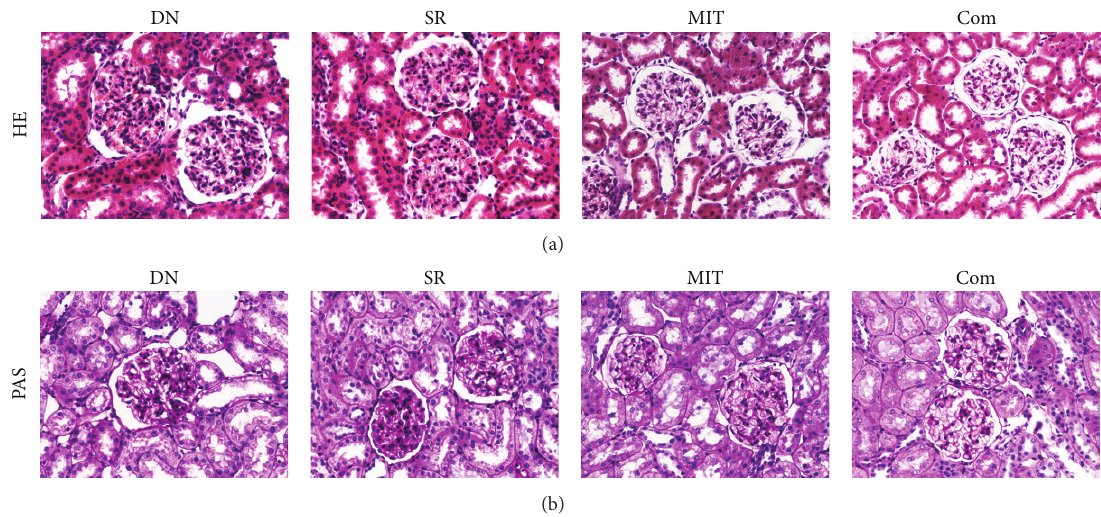
Figure 4: Histopathological staining of the renal tissues (original magnification × 400). HE staining (a) and PAS staining (b) were performed to observe the pathological changes in glomeruli and tubules in each group.